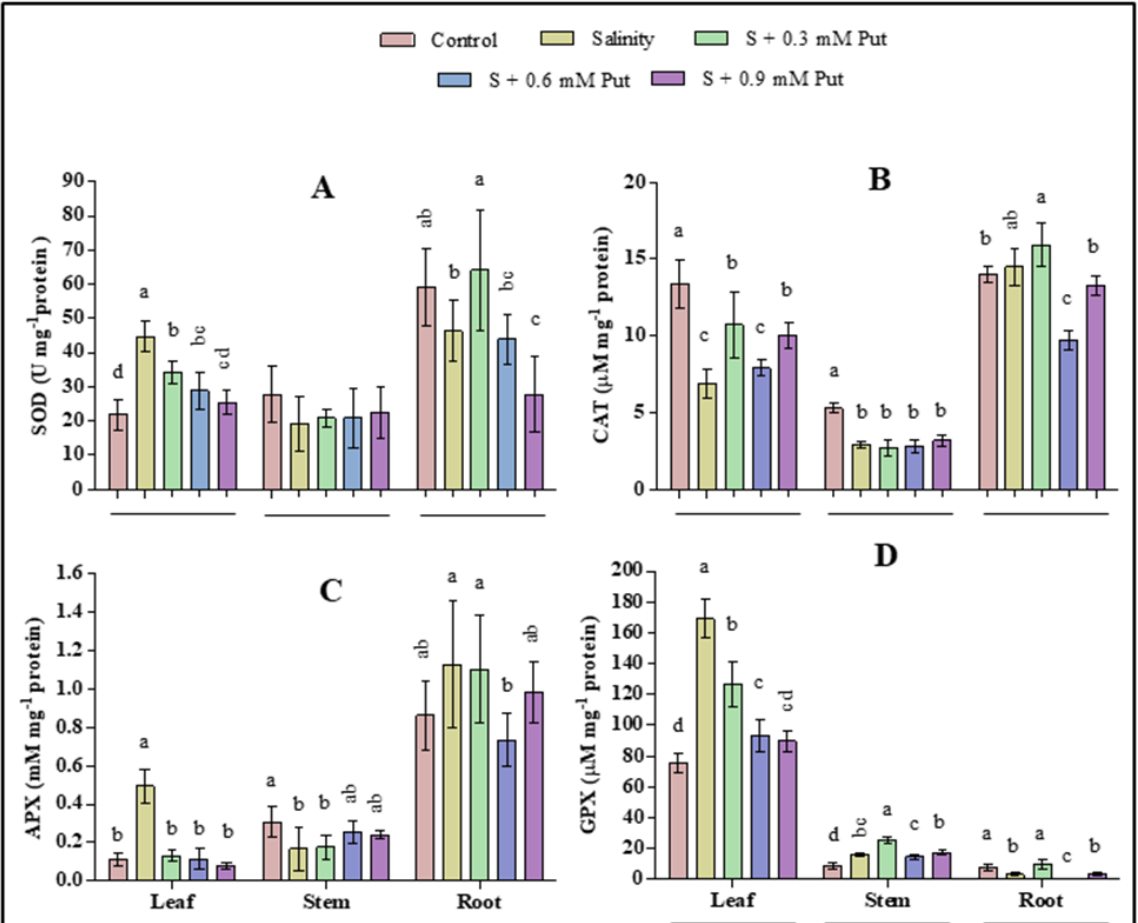
Figure 4 . Effect of Putrescine on antioxidant enzymes (superoxide dismutase, SOD; catalase, CAT; ascorbate peroxidase, Figure 4. Effect of Putrescine on antioxidant enzymes (superoxide dismutase ( A ), SOD; catalase ( B ), CAT; ascorbate APX; and guaiacol peroxidase, GPX) activities in leaves of ginseng seedlings under salinity stress condition. Different peroxidase ( C ), APX; and guaiacol peroxidase ( D ), GPX) activities in leaves of ginseng seedlings under salinity stress letters indicate significant differences (P ≤ 0.05) among the treatments within each parameter. Each value represents the condition. Different letters indicate significant differences ( P ≤ 0.05) among the treatments within each parameter. Each mean ± SD (n = 4). value represents the mean ± SD ( n =